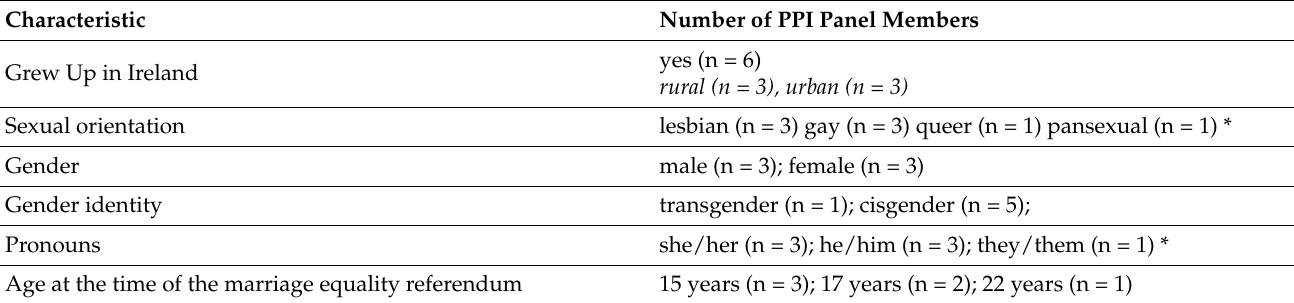
Table 1. PPI Panel member’s